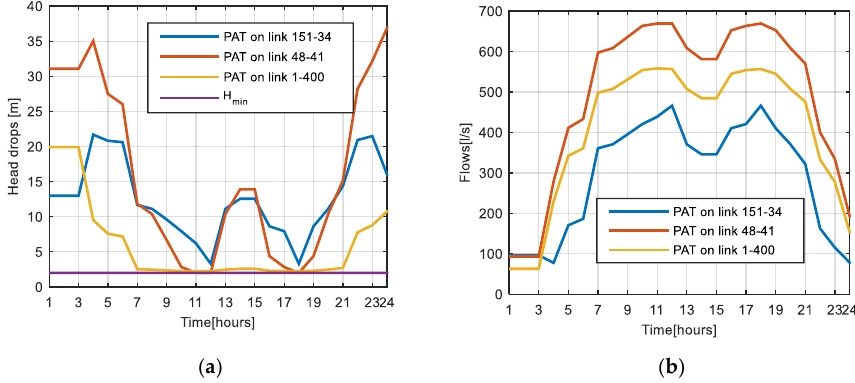
Figure 13. The hourly head drops ( a ) and flows through PATs ( b ).